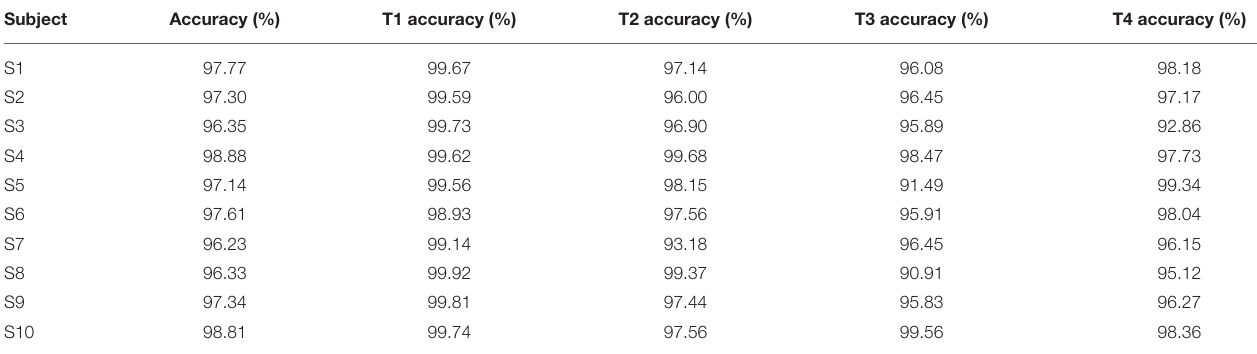
TABLE 2 | The classification accuracy of individual